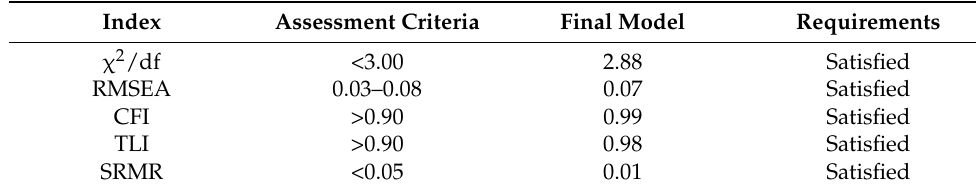
Table 5. Results of different model fit indices for